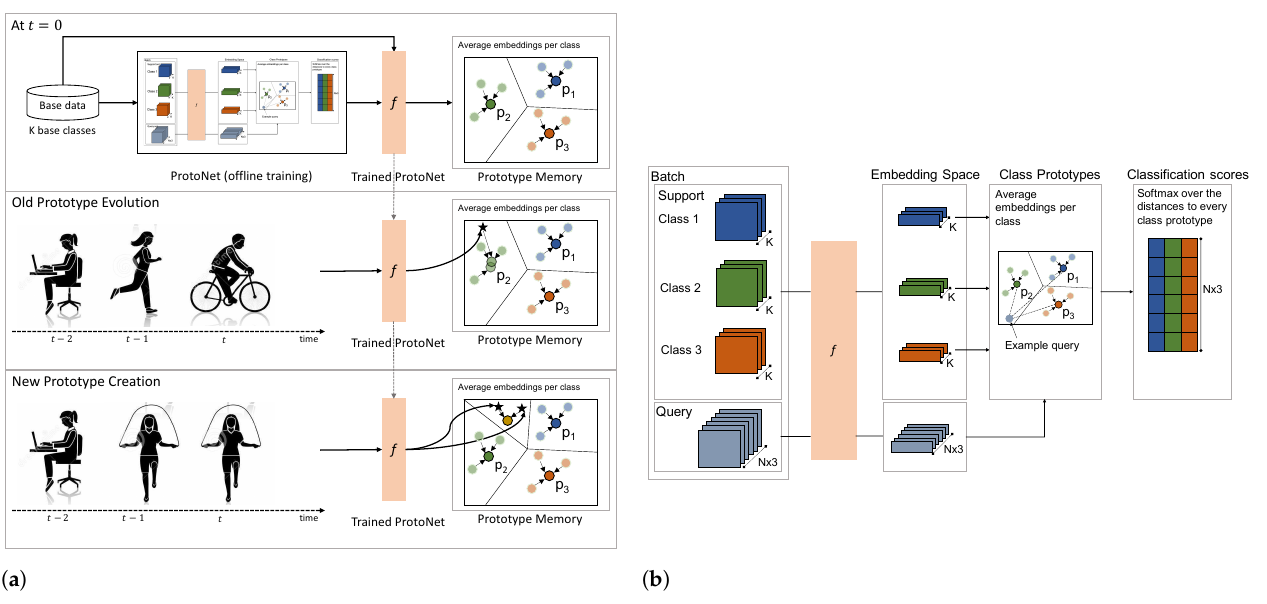
Figure 2. ( a ) Incremental prototype memory refinement: old prototype evolution using online averaging and new prototype creation when encountering a new activity. ( b ) Offline Pretraining of Prototypical Network using standard few-shot learning